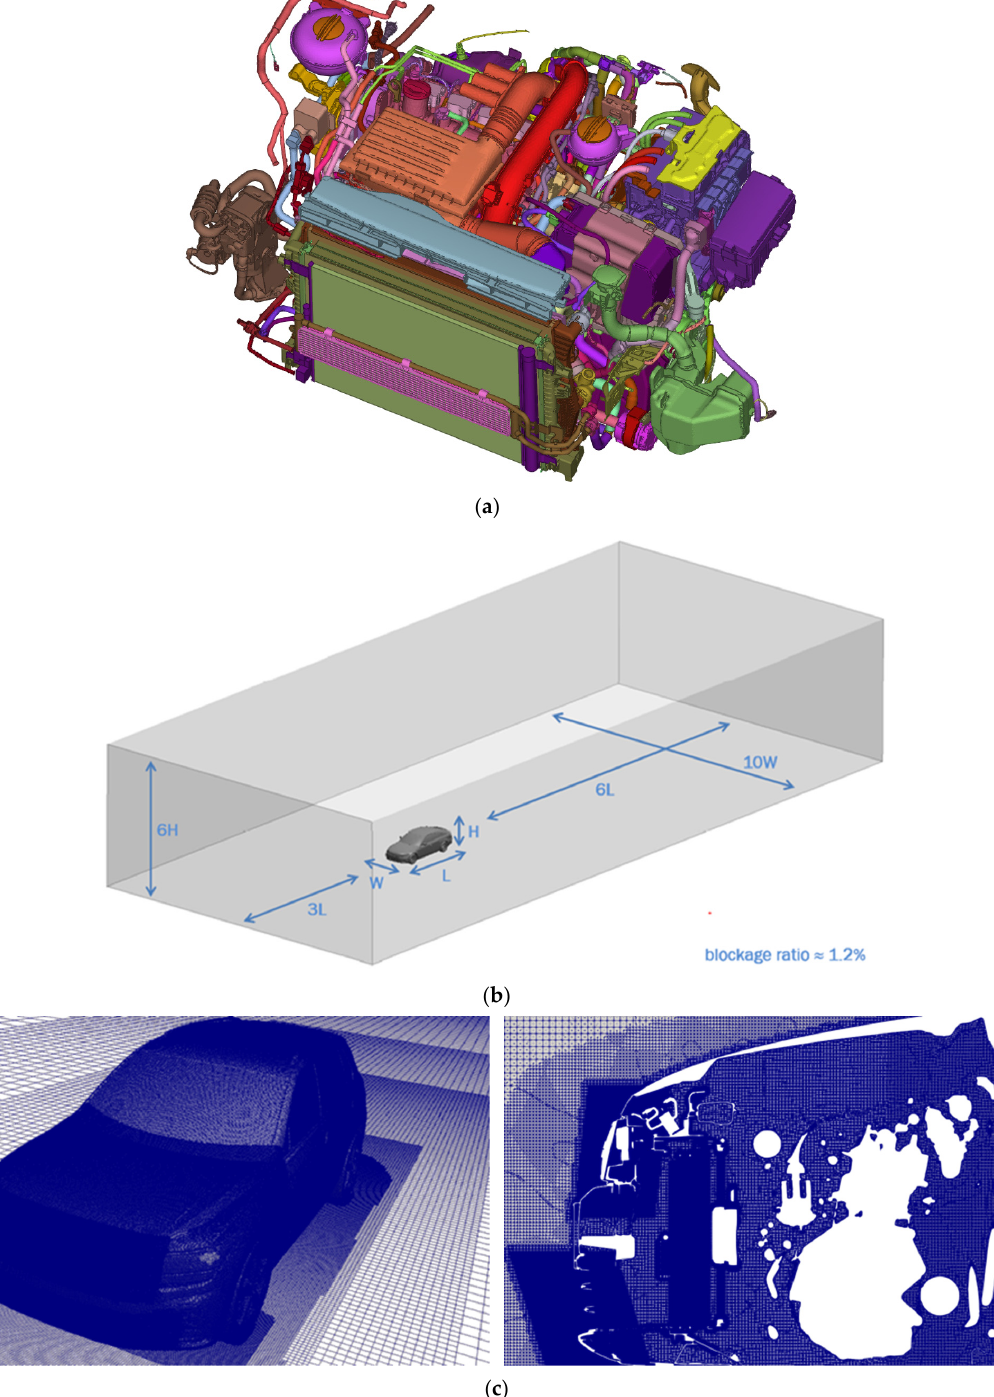
Figure 3. The 3 D model of the underhood for PHEV. ( a ) A 3D solid model of the underhood; ( b ) the CFD calculation domain of the underhood for PHEV; ( c ) the mesh of the underhood for PHEV.